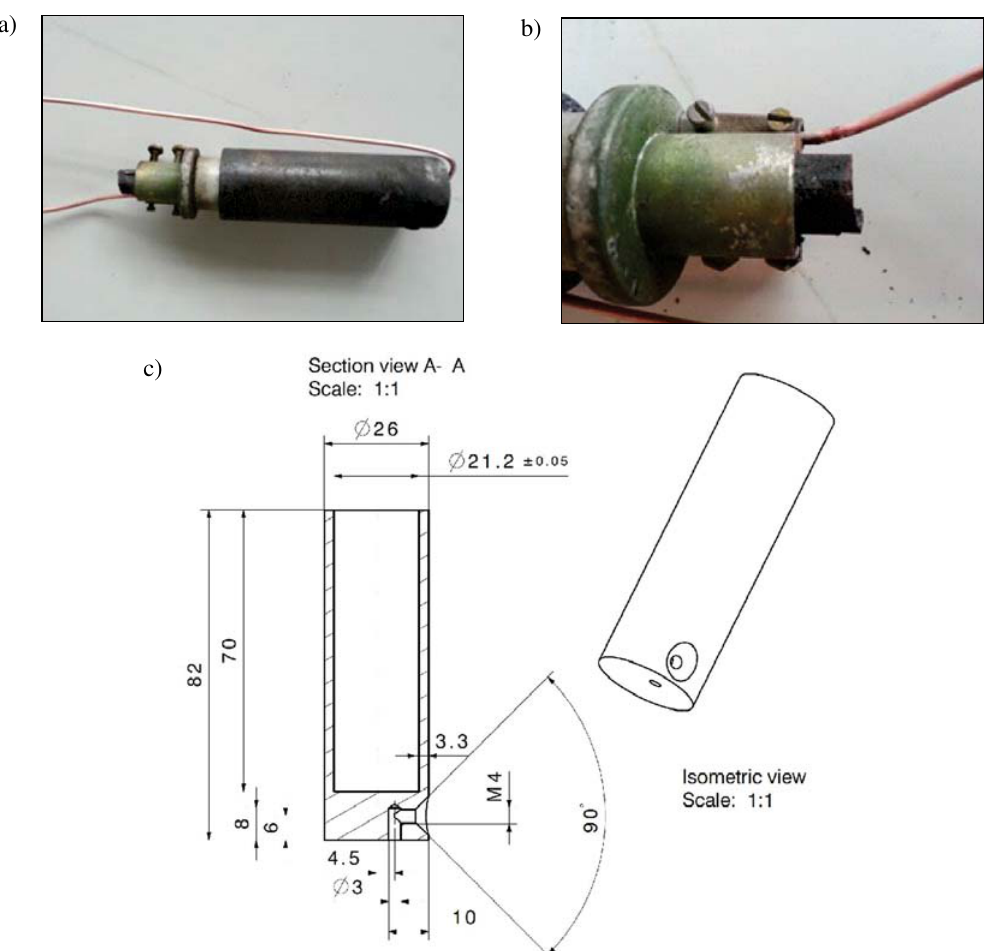
Figure 2. (a) Full battery cell equipped with connectors and Cu wires after electrochemical measurements in inert (Ar) atmosphere at 750 °C, (b) detailed image of stainless steel lid with inner coaxial graphite stick; note that both the surface of the stainless steel container and the stainless steel lid are covered with some product(s) of corrosion processes that are taking place at such high temperatures when subjected to vapors of electrolyte components. (c) Technical drawing of the